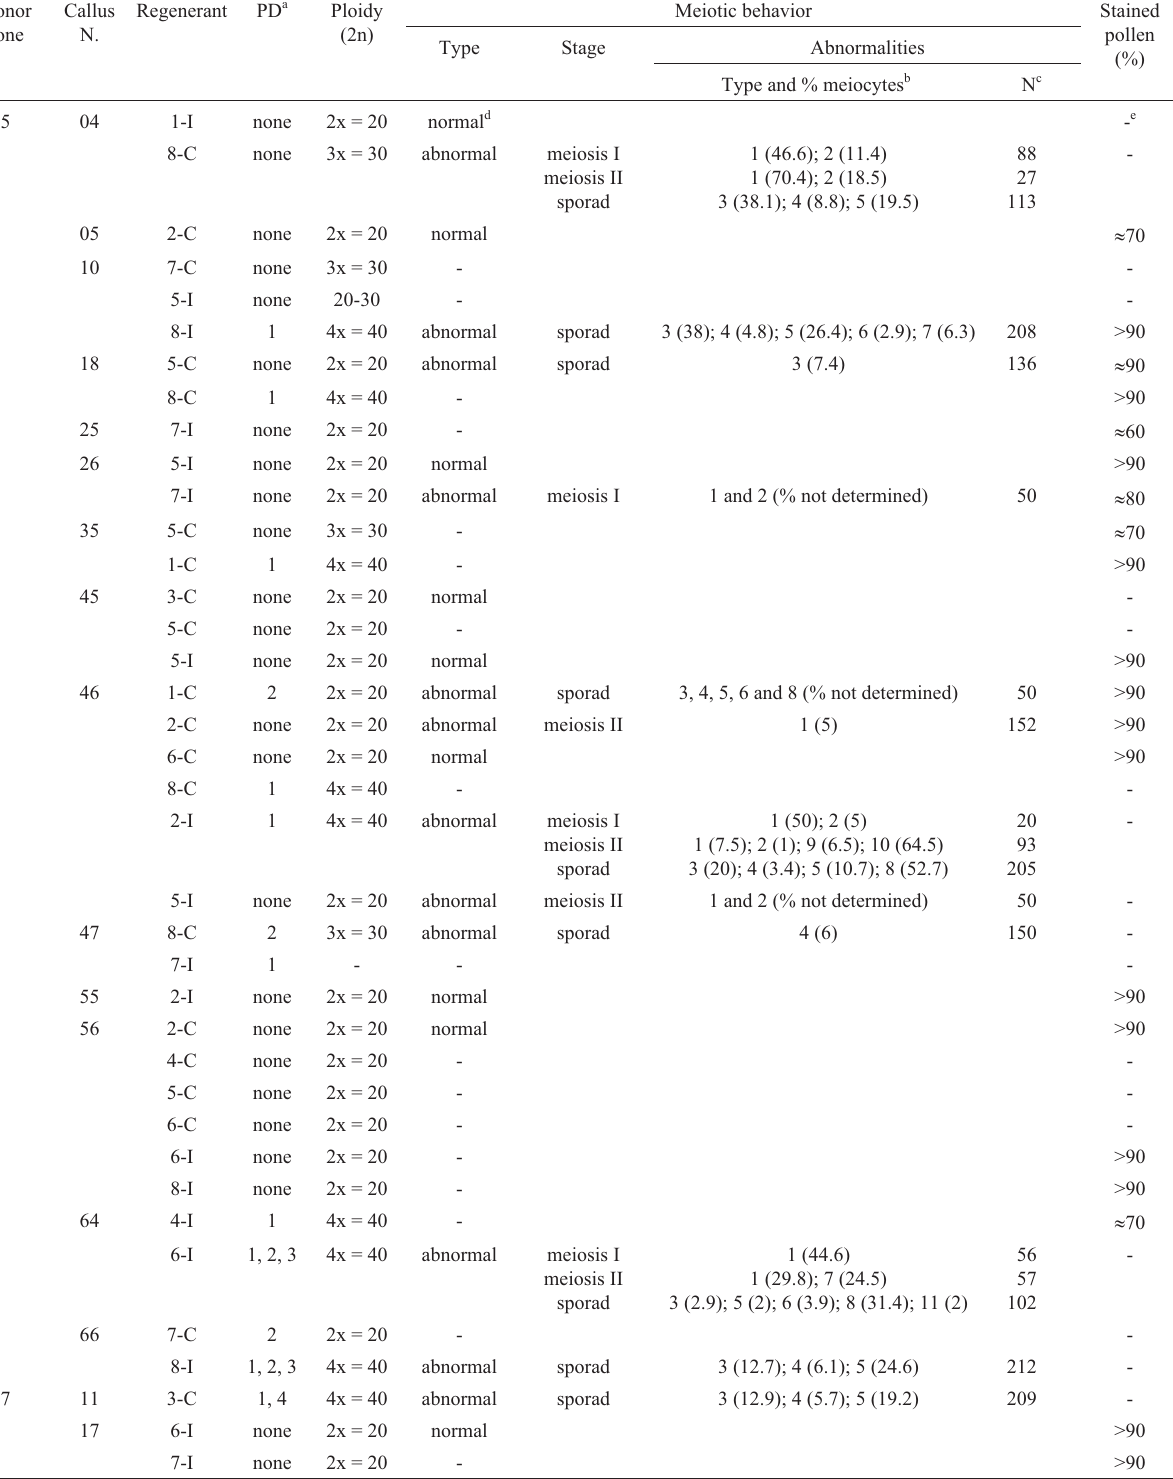
Table 2 - Phenotypic deviation from the donor clone, ploidy, meiotic behavior and pollen staining in regenerants derived from clones 265 and 357. Donor Callus clone